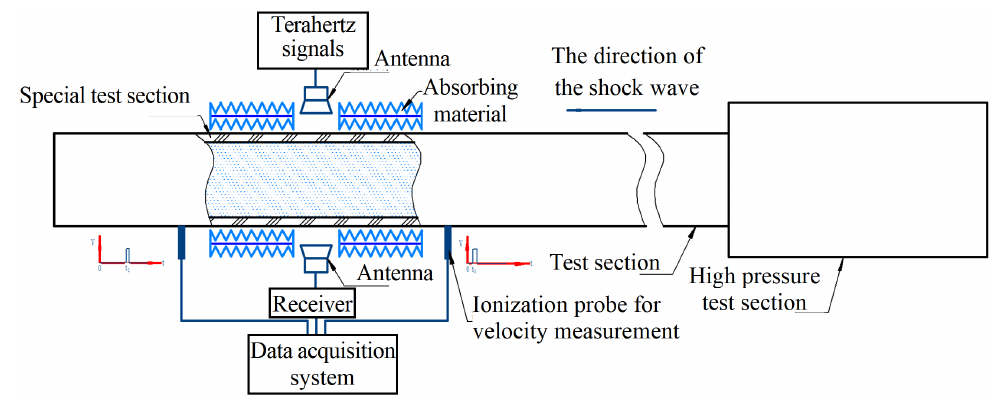
Figure 1. The schematic of the shock-wave tube system to produce the plasma and THz measure- ment system.